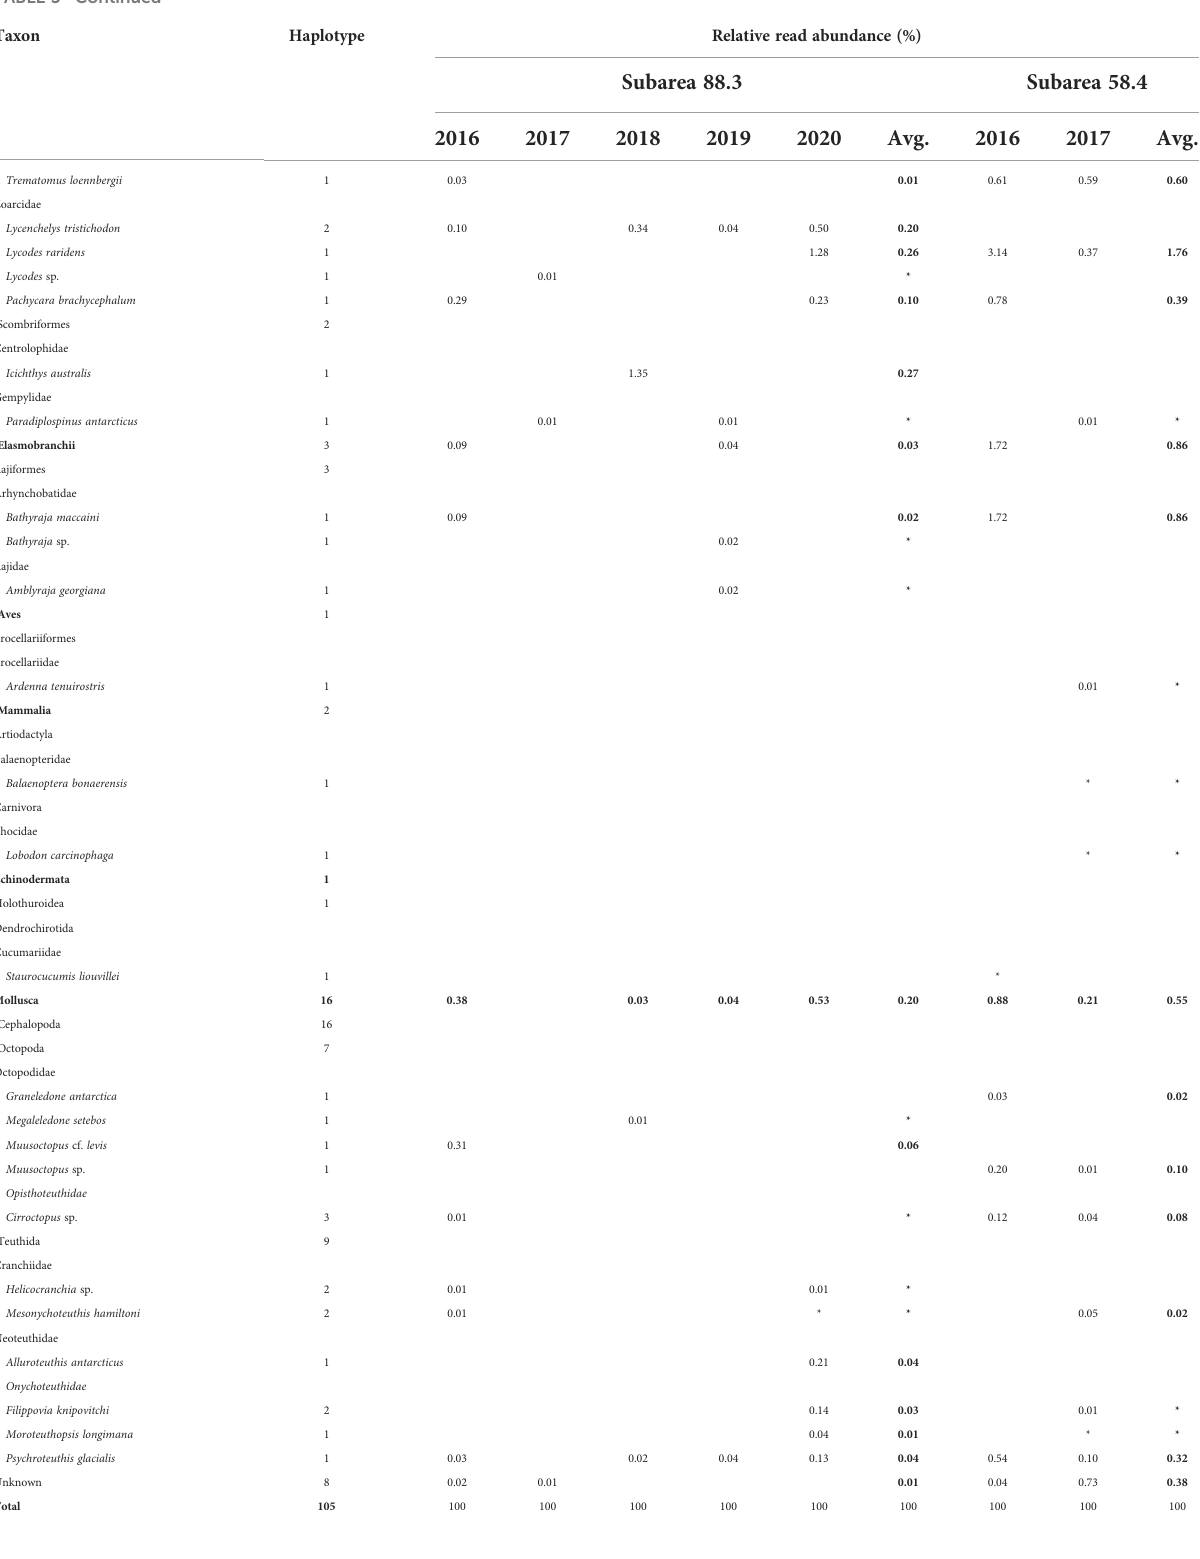
*Lower than 0.01%. Bold text indicates the phylum or class among taxa, and the bold number indicates the average